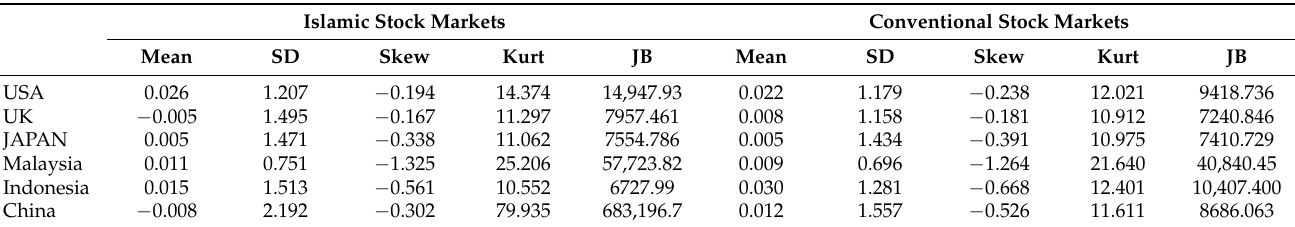
Table 2. Summary of the descriptive